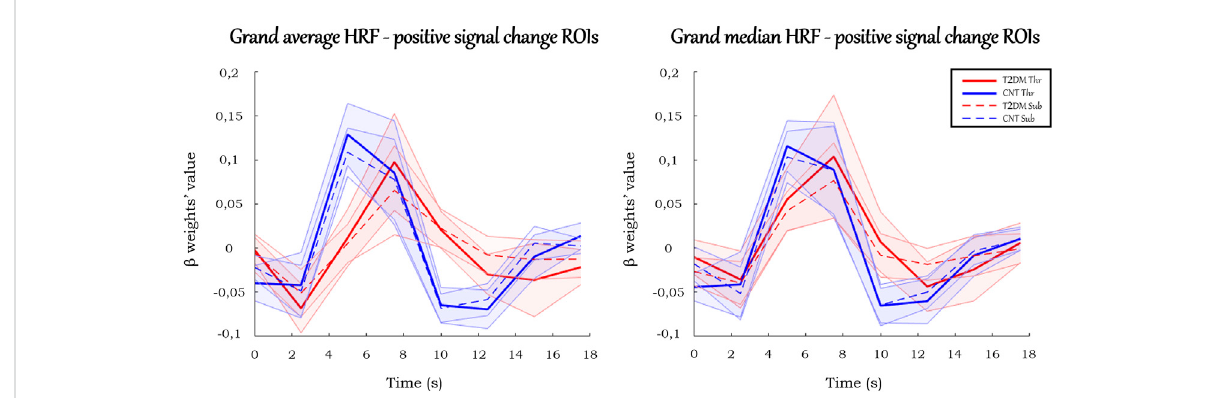
FIGURE 4 GrandaverageandgrandmedianHRFcurvesintheROIswithpositivesignalchange.Solidanddashedthicklinesrepresenttheaverage/median for each condition, and the shaded areas represent the standard deviation/interquartile range.